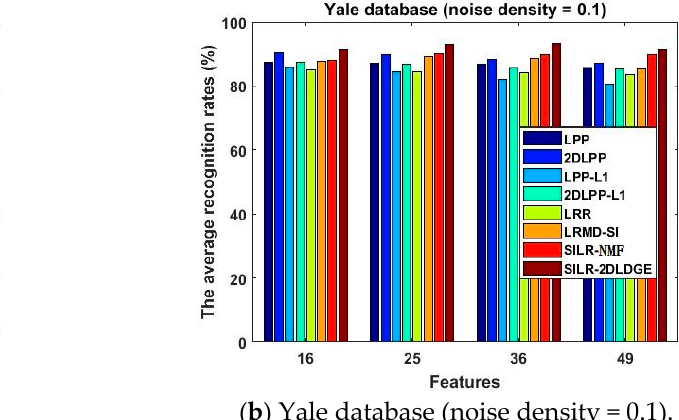
Figure 7. The average recognition rates (%) of the eight algorithms in the Yale database vary with the dimension.